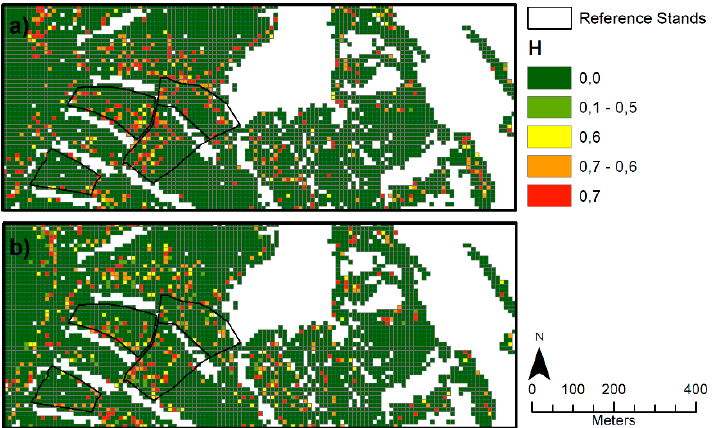
Figure 7. Maps of Shannon’s diversity index over grid cell (10 × 10 m): ( a ) Multisource-based method and ( b ) Raster-based method.